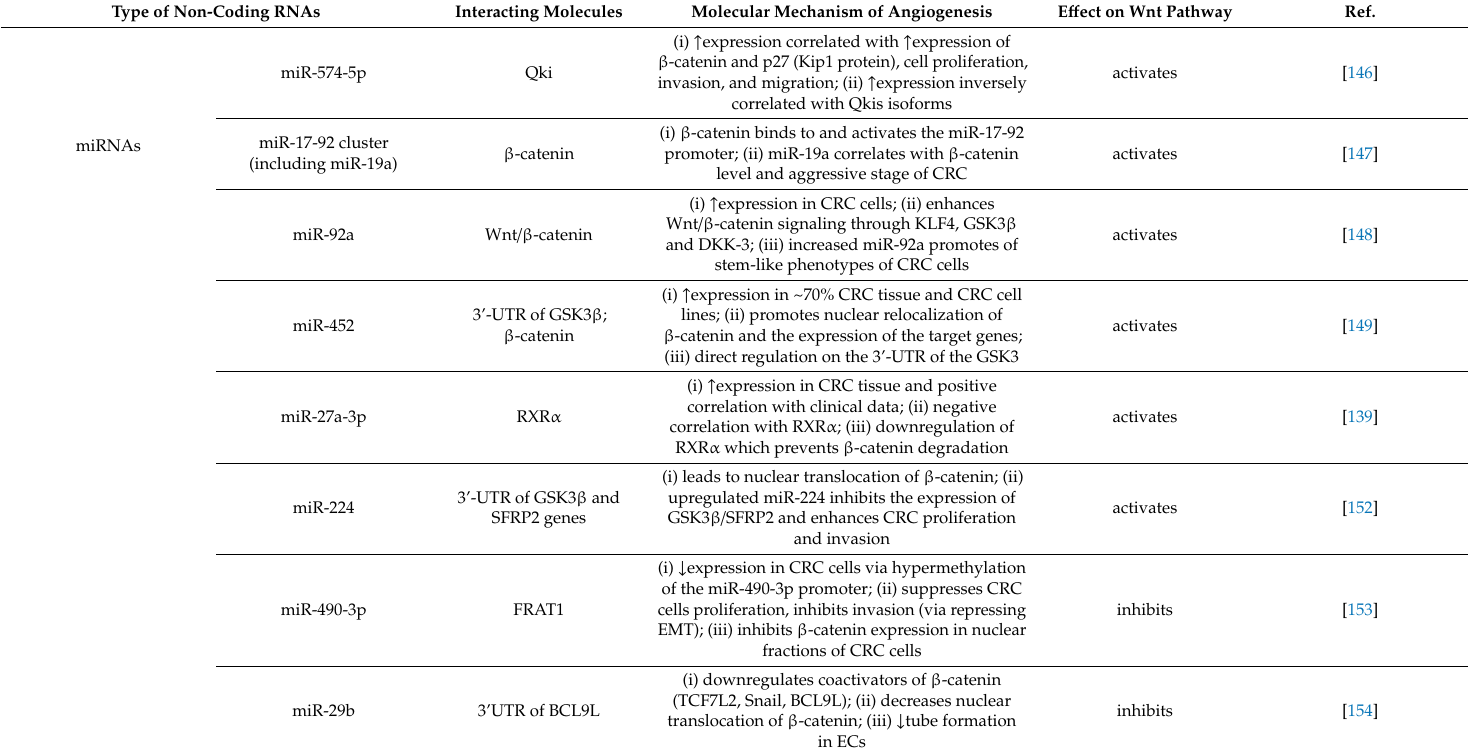
Table 2. The role of selected non-coding RNAs in colorectal cancer (CRC) angiogenesis regulated by Wnt / β -catenin signaling-mediated